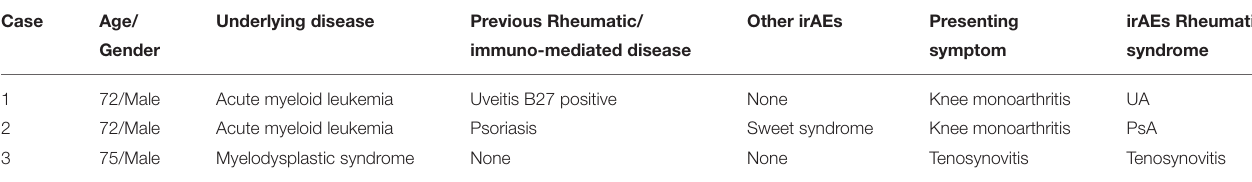
TABLE 3 | Clinical characteristics of patients treated with Anti-TIM3.